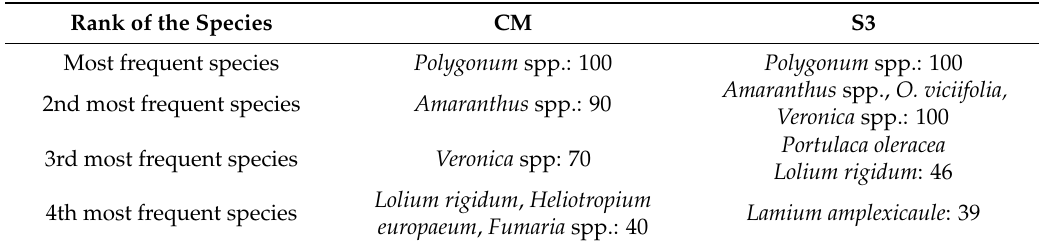
Table 10. Percentage frequency of the most frequent species found in the different crops. CM: cereal monocrop, S3: sainfoin in the third